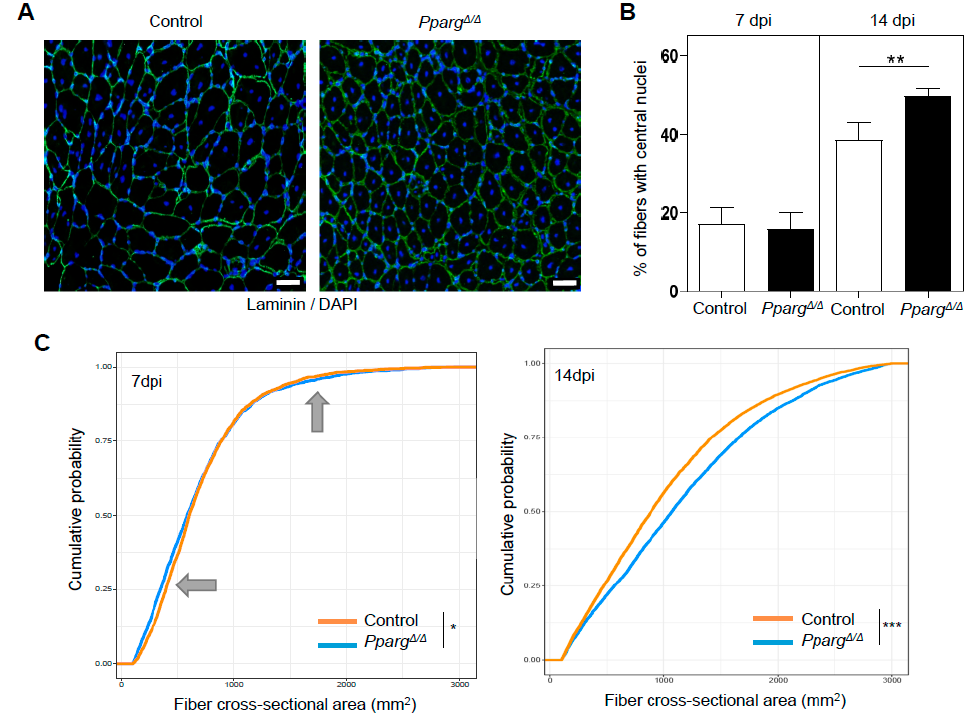
Figure 3. Muscle regeneration is impaired in Pparg ∆ / ∆ mice. ( A ) Representative images of Pparg ∆ / ∆ and control muscle sections stained with Laminin and DAPI at 14dpi. Scale bar: 50 µ m. ( B ) Quantification of the percentage of fibers possessing centralized nuclei at 7 and 14dpi, with n=7 mice per group. ( C ) Cumulative distribution of cross sectional area of regenerating fibers with centralized nuclei in regenerating muscles of Pparg ∆ / ∆ and control littermates mice at 7dpi (left panel) and 14dpi (right panel). Gray arrows depict the bimodal differences of Pparg ∆ / ∆ and control cross sectional area distributions. n = 7 mice per group. *** p = 0.001, ** p = 0.01, * p < 0.05 by Mann–Whitney test ( B ) or Kolmogorov–Smirnov test ( C ).